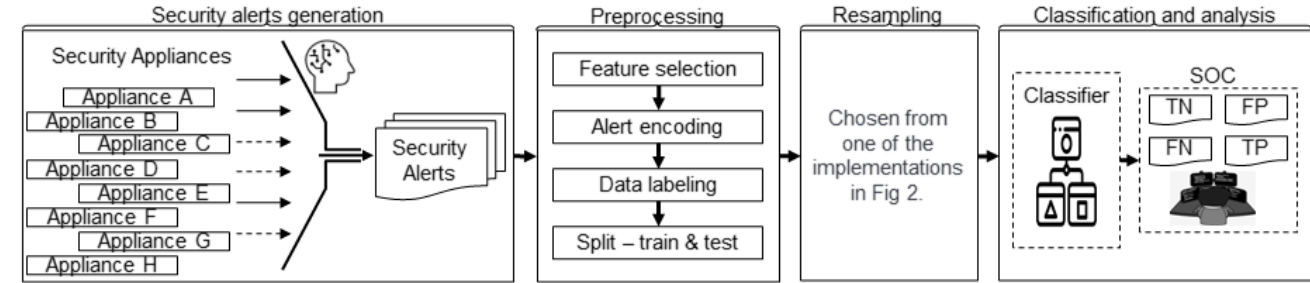
Figure 1. Proposed system framework for AI-assisted security alert data